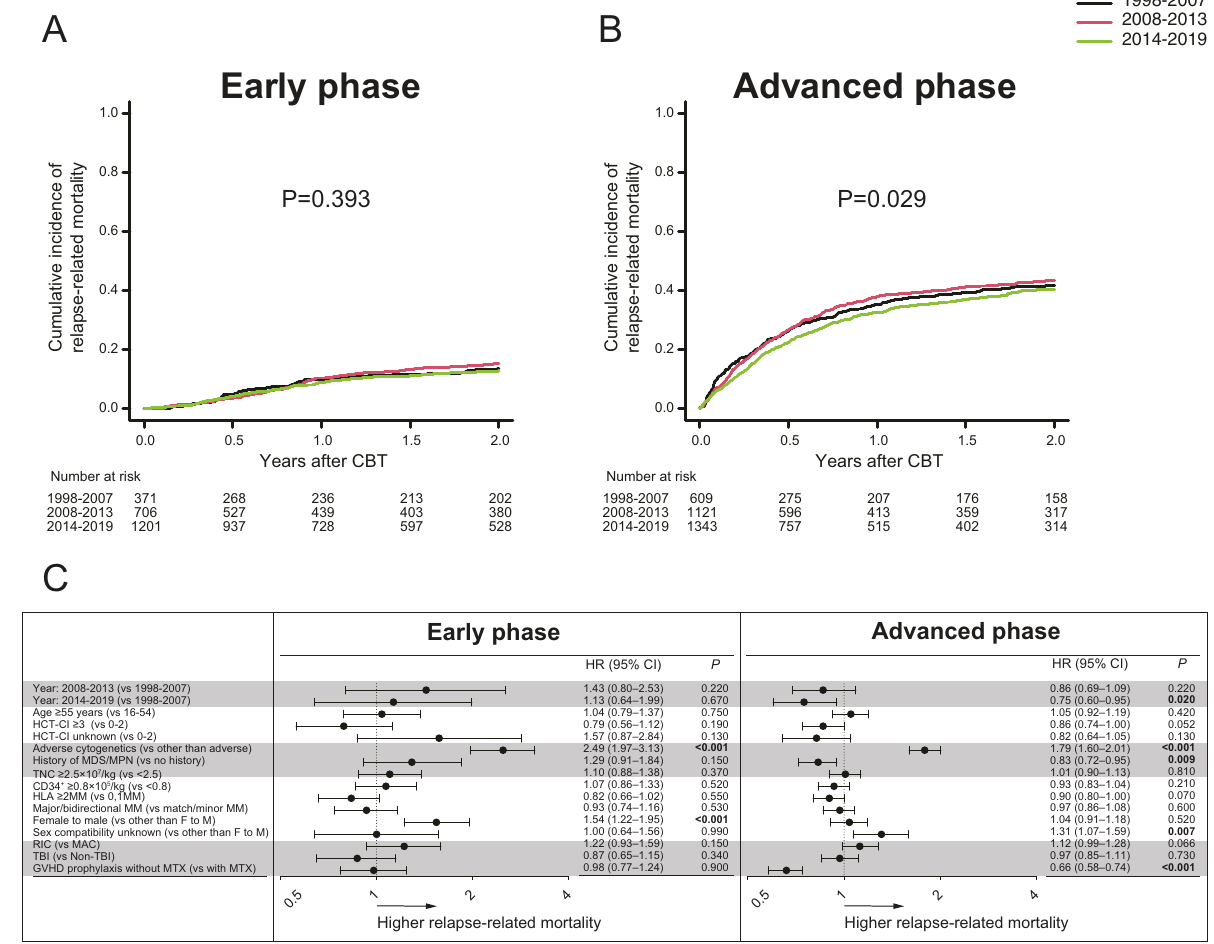
Fig. 3 Relapse-related mortality after CBT according to disease status at CBT. The cumulative incidences of relapse-related mortality after CBT according to the three time periods in patients with early phase at CBT ( A ), or advanced phase at CBT ( B ). Forest plots for the adjusted hazard ratios (HR) and 95% con fi dence intervals (CI) of relapse-related mortality among each cohort in the multivariate analysis ( C NRM was signi fi cantly lower in the last period 2014 – 2019 (HR,0.71, P = 0.003) but not 2008 – 2013 (HR,0.83, P = 0.110) (Fig. 1D). In relation to other factors associated with NRM, age ≥ 55 years (HR,1.55, P < 0.001), HCT-CI ≥ 3 (HR,1.57, P < 0.001), unknown status of HCT-CI (HR,1.32, P = 0.022), adverse cytogenetic risk (HR,0.86, P = 0.030), history of MDS/MPN (HR,1.16, P = 0.028), HLA disparities ≥ 2 mismatch (HR,1.22, P < 0.001), and GVHD prophy- laxis without MTX (HR,1.34, P < 0.001) were also signi fi cantly associated with NRM (Fig. 1D). Among two distinct cohorts, in the univariate analysis, the 2-year NRM signi fi cantly improved over time among patients with early phase at CBT ( P < 0.001) and advanced phase at CBT ( P = 0.010) (Fig. 4A, B). In the multivariate analysis, compared with 1998 – 2007, NRM was signi fi cantly lower in the last period 2014 – 2019 among patients with early phase at CBT (HR,0.58, P = 0.009) (Fig. 4C). Hematopoietic engraftments For the entire cohort, the cumulative incidences of neutrophil and platelet engraftment were 80.0% (95%CI, 78.9 – 81.0%) at 42 days and 65.1% (95%CI, 63.8 – 66.3%) at 100 days after CBT, respectively. Improvements of neutrophil and platelet engraft- ment were observed in the periods 2008 – 2013 and 2014 – 2019 compared with 1998 – 2007 in the univariate and multivariate analyses (Fig. S1A – C).